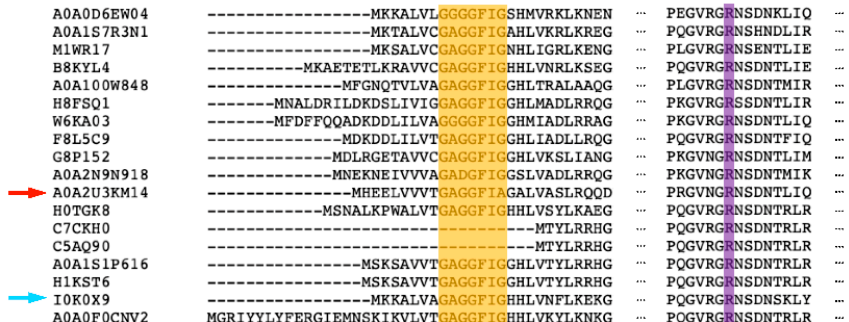
Figure 5. Multiple sequence alignment of the 18 putative bacterial GM35Es found in UniProt. The GxxGxxG motif is highlighted in yellow, whereas the conserved arginine (R) is colored in purple. The variants are represented by their UniProt code. The bacterial GM35E displaying the alternative GxxGxxA motif is marked by a red arrow, and Mf GM35E is indicated by a blue arrow.